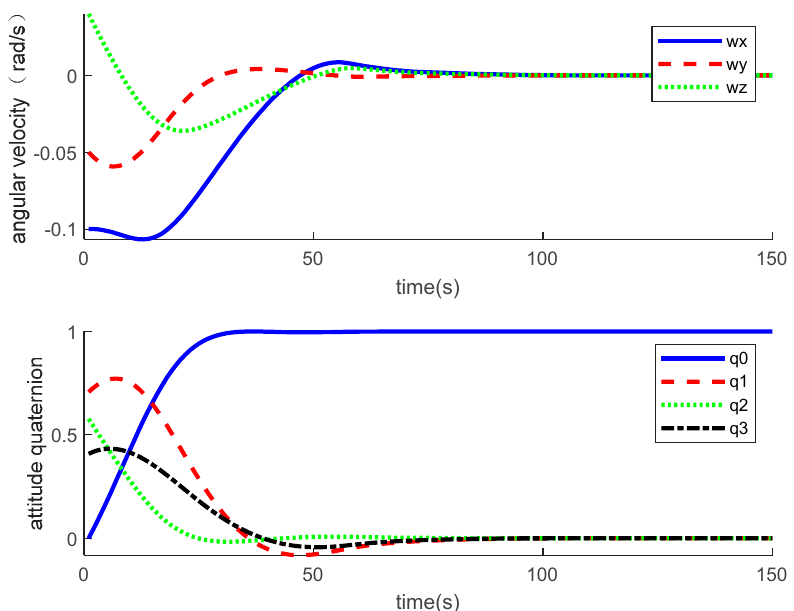
Figure 8. Curve of the system state under the finite time controller from reference [20] with actuator failure.